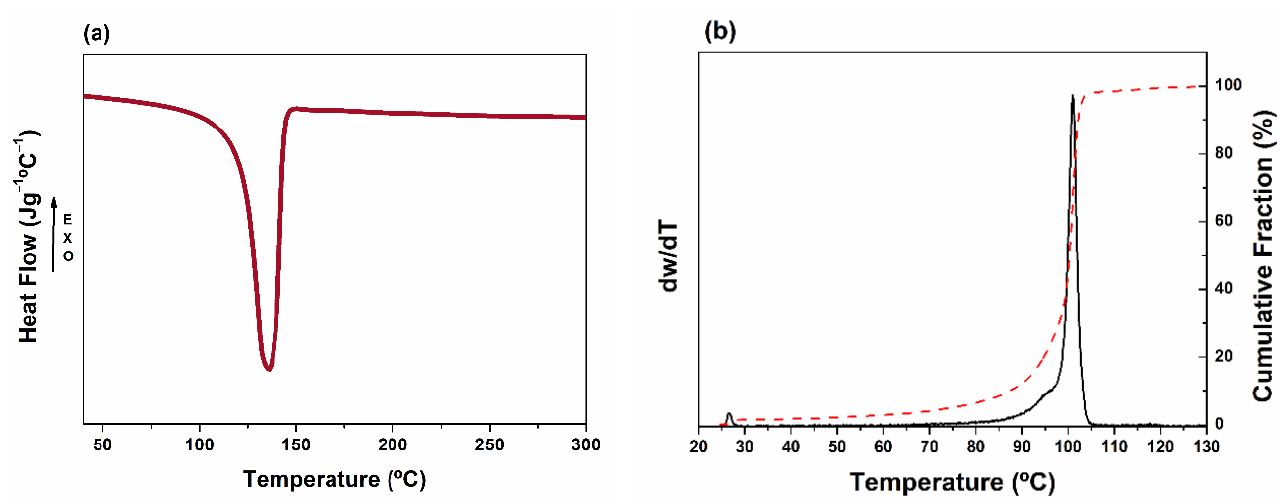
Figure 4. ( a ) DSC melting thermogram and ( b ) TREF curves for the recycled fishing net (rFN).